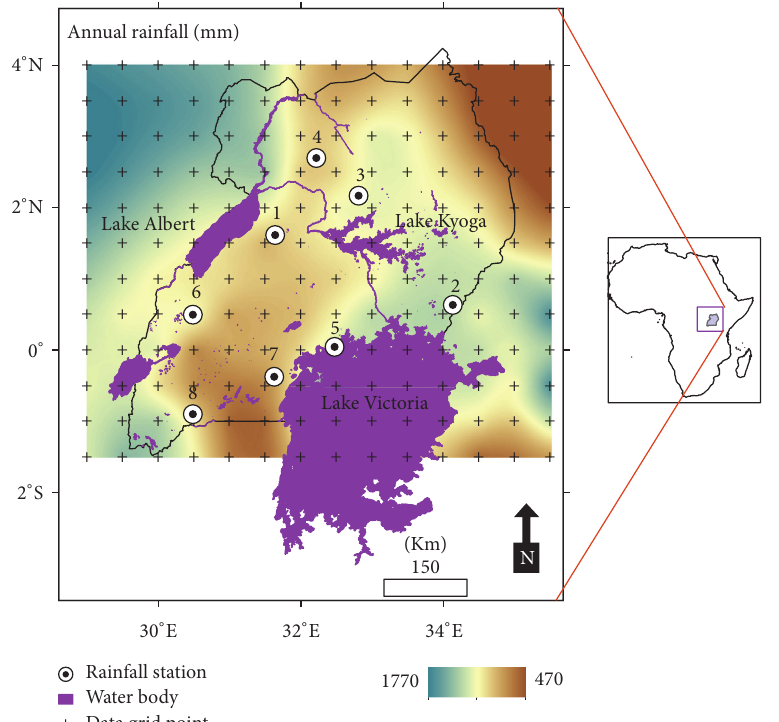
Figure 1: The study area showing the spatial domain of the rainfall data and locations of some selected meteorological stations (see Table 1 for details). The background map is the annual rainfall total (mm) obtained by surface interpolation (kriging method) based on data from